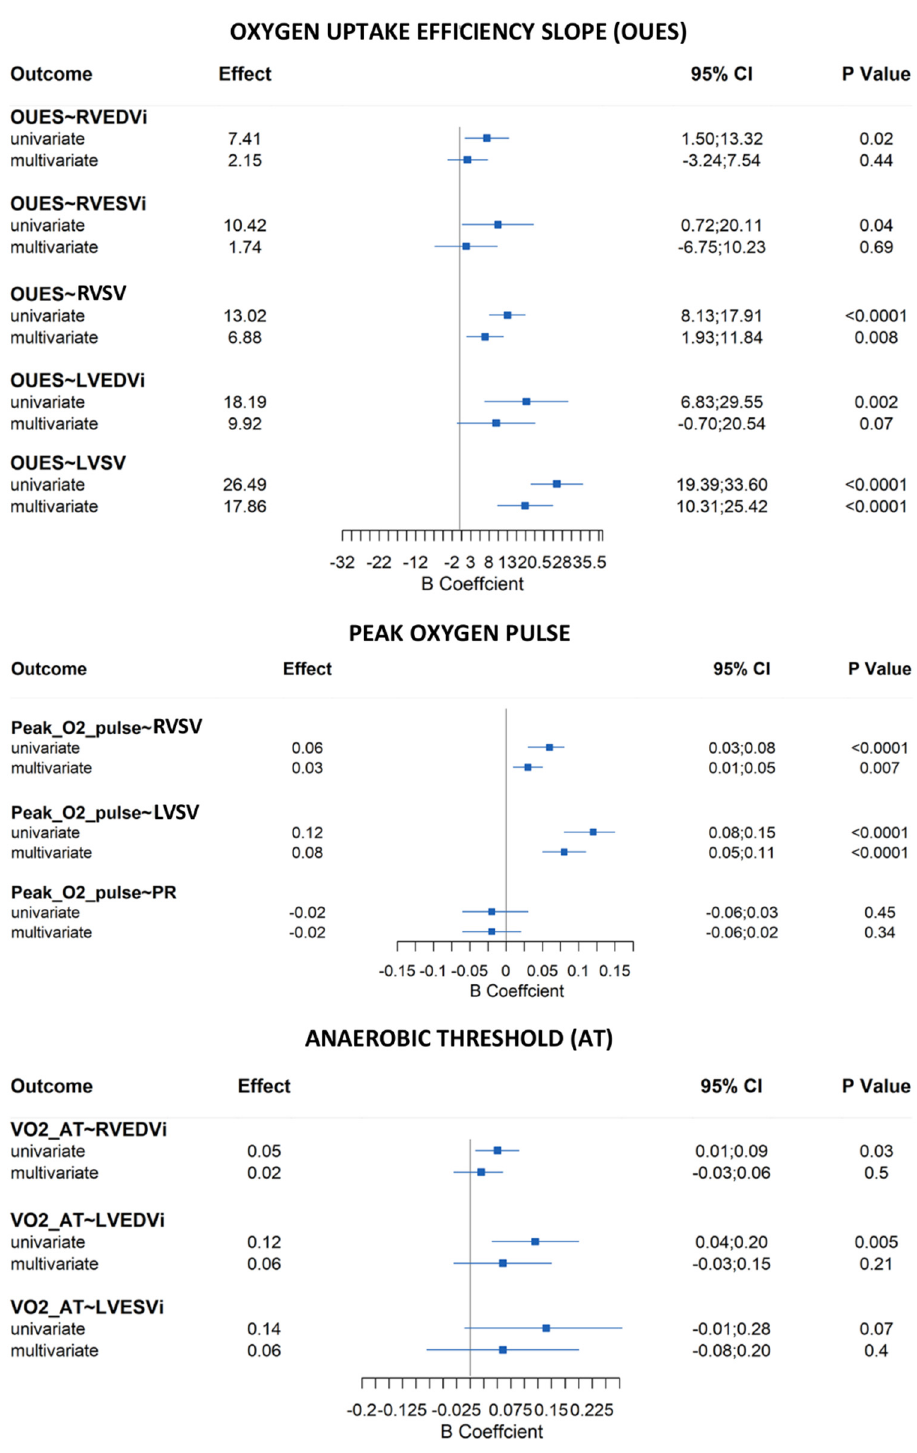
Figure 3. OUES, peak O 2 pulse and anaerobic threshold coefficients from univariate and confounder adjusted multivariate regression models (only the statistically significant values are reported in this figure. The other figure with the statistically insignificant correlations is reported in the supplemental material). Legend: LVEDVi: left ventricular end-diastolic volume normalized for body surface area; LVESVi: left ventricular end-systolic volume normalized for body surface area; LVSV: left ventricular stroke volume; RVEDVi: right ventricular end-diastolic volume normalized for body surface area; RVESVi: right ventricular end-systolic volume normalized for body surface area; RVSV: right ventricular stroke